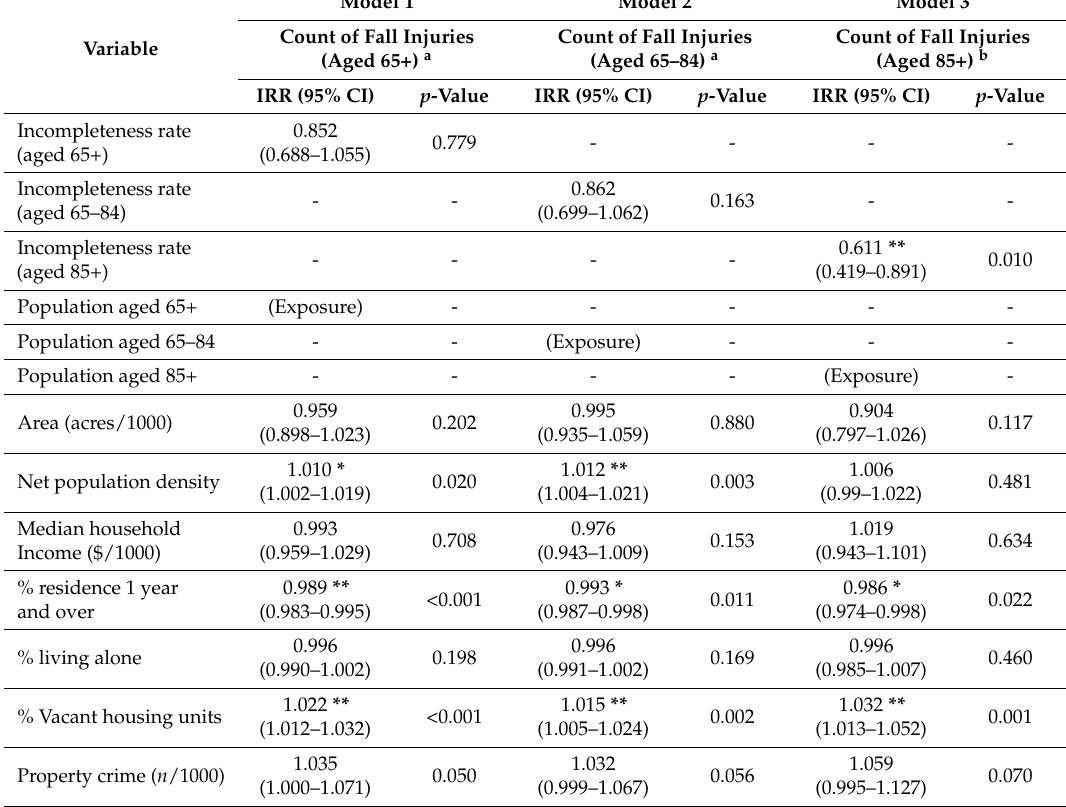
Table 4. Multivariable-adjusted analysis: Neighborhood context and count of fall-related injuries at the census tract level ( n =